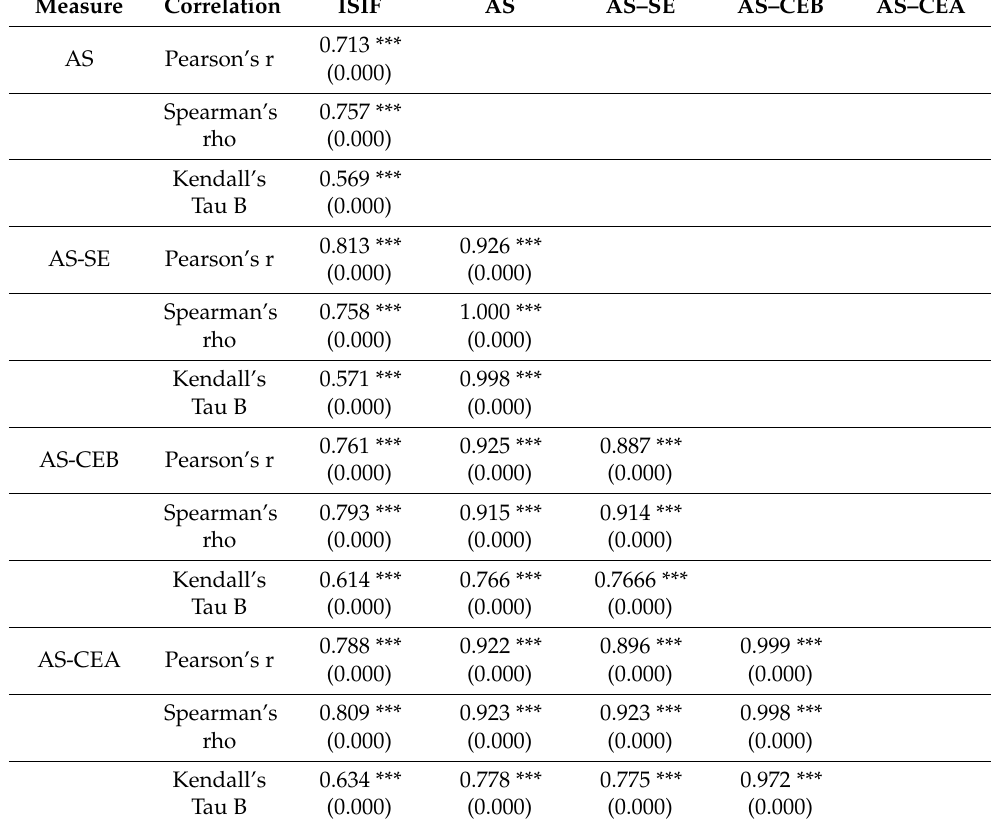
Table 10. Correlation matrix.